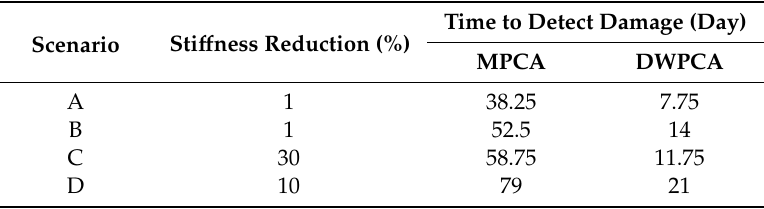
Table 2. Time to detect damage of MPCA and DWPCA for di ff erent